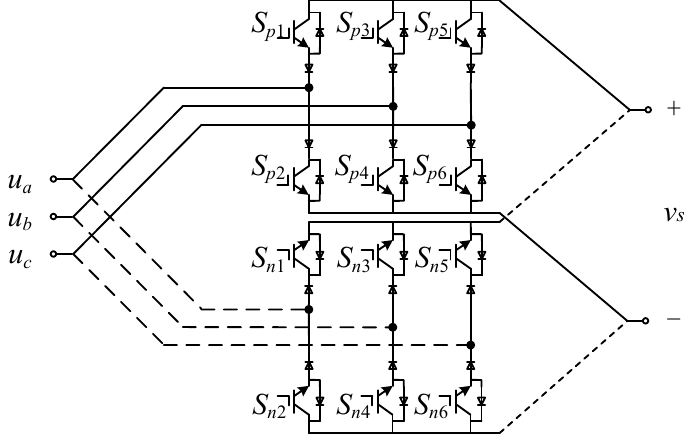
Figure 2. De-coupling diagram of direct three-phase AC–AC matrix converter.